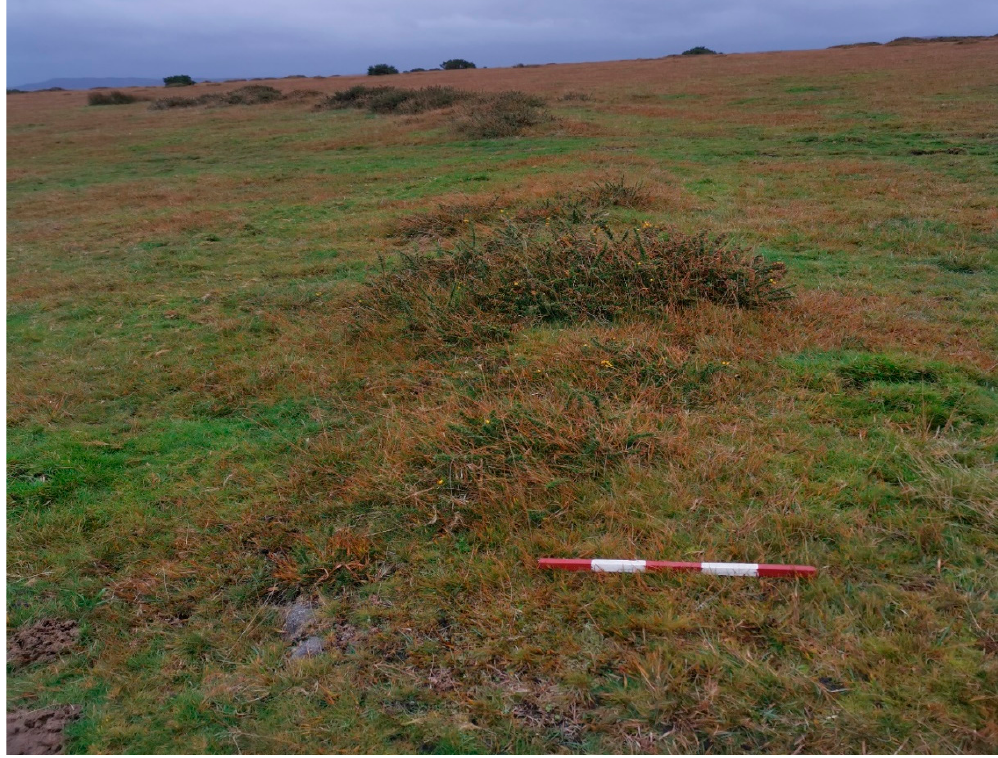
Figure 6. Partially buried stone sections of the Ladydown Common enclosures. Scale 50 cm (Photograph: Richard Grove).